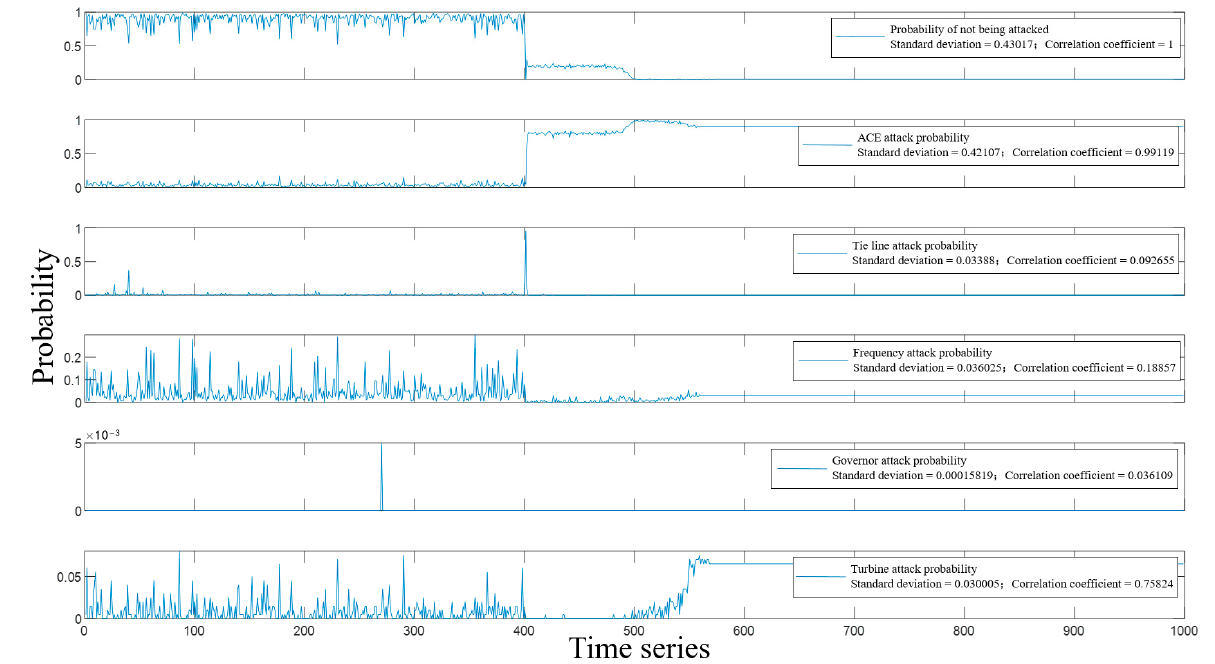
Figure 8. Detection Value of Mixed Attack Probability of ACE and Tie-Line.